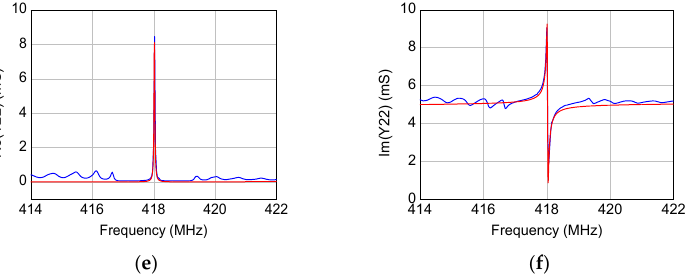
Figure 6. Comparison between (blue) measured and (red) simulated frequency-dependent behavior of ( a , b ) Y 11 , ( c , d ) Y 21 , and ( e , f ) Y 22 for the 418.05 MHz SAW resonator.